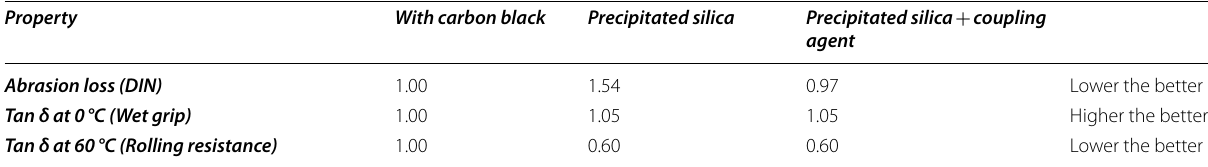
Table 2 Results of comparison between silica fillers and carbon black in tire tread formulation [27] Property With carbon